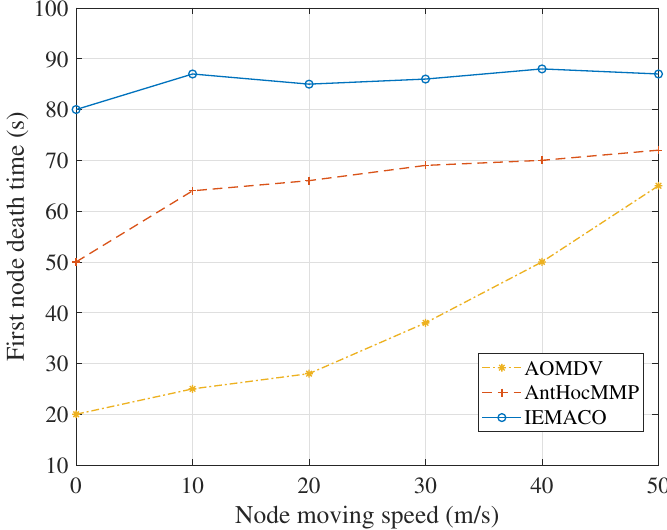
Figure 6. First node death time versus node moving speed.